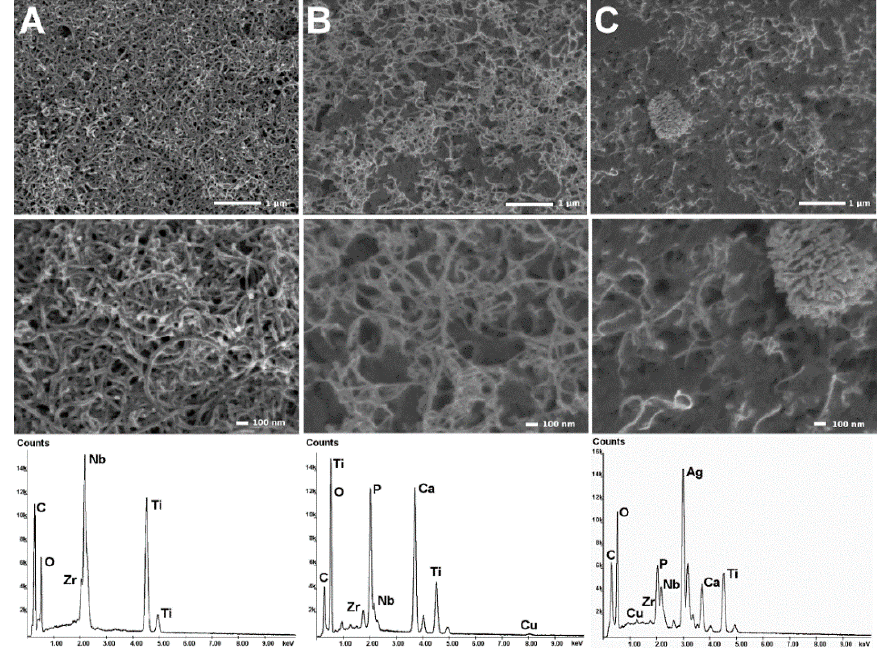
Figure 2. SEM surface topography with the energy dispersive spectrometer (EDS) spectrum of the sample: ( A ) 0.27CNT, ( B ) H0.27CNT, ( C ) m0.4CNT.